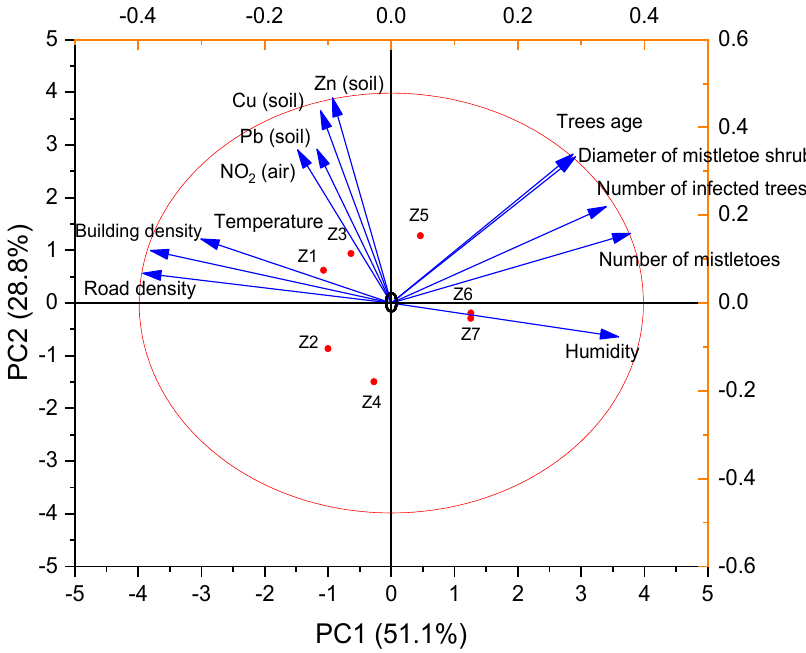
Figure 2. Principal component analysis (PCA) biplot of the concatenated data exhibiting the correlation between mistletoe occurrence parameters and landscape, climatic, and environmental factors.